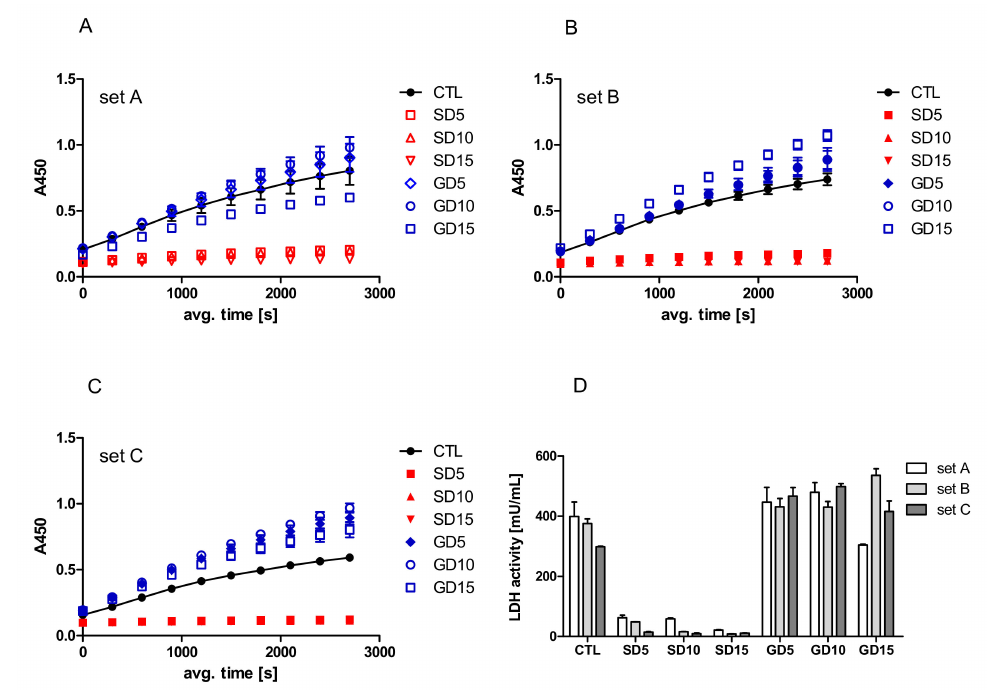
Figure 8. Effect of SD and GD PAW and their activation times on the enzymatic activity of lactate dehydrogenase (LDH); absorbance at A450 indicates reduction of NAD to NADH. Graphs show the results of three sets of PAW, generated at different time points but tested simultaneously. ( A ) Set A 2 weeks after generation; ( B ) set B 1 week after generation; ( C ) set C 1 day after PAW generation; ( D ) average LDH activity for all sets (data shown as mean ±